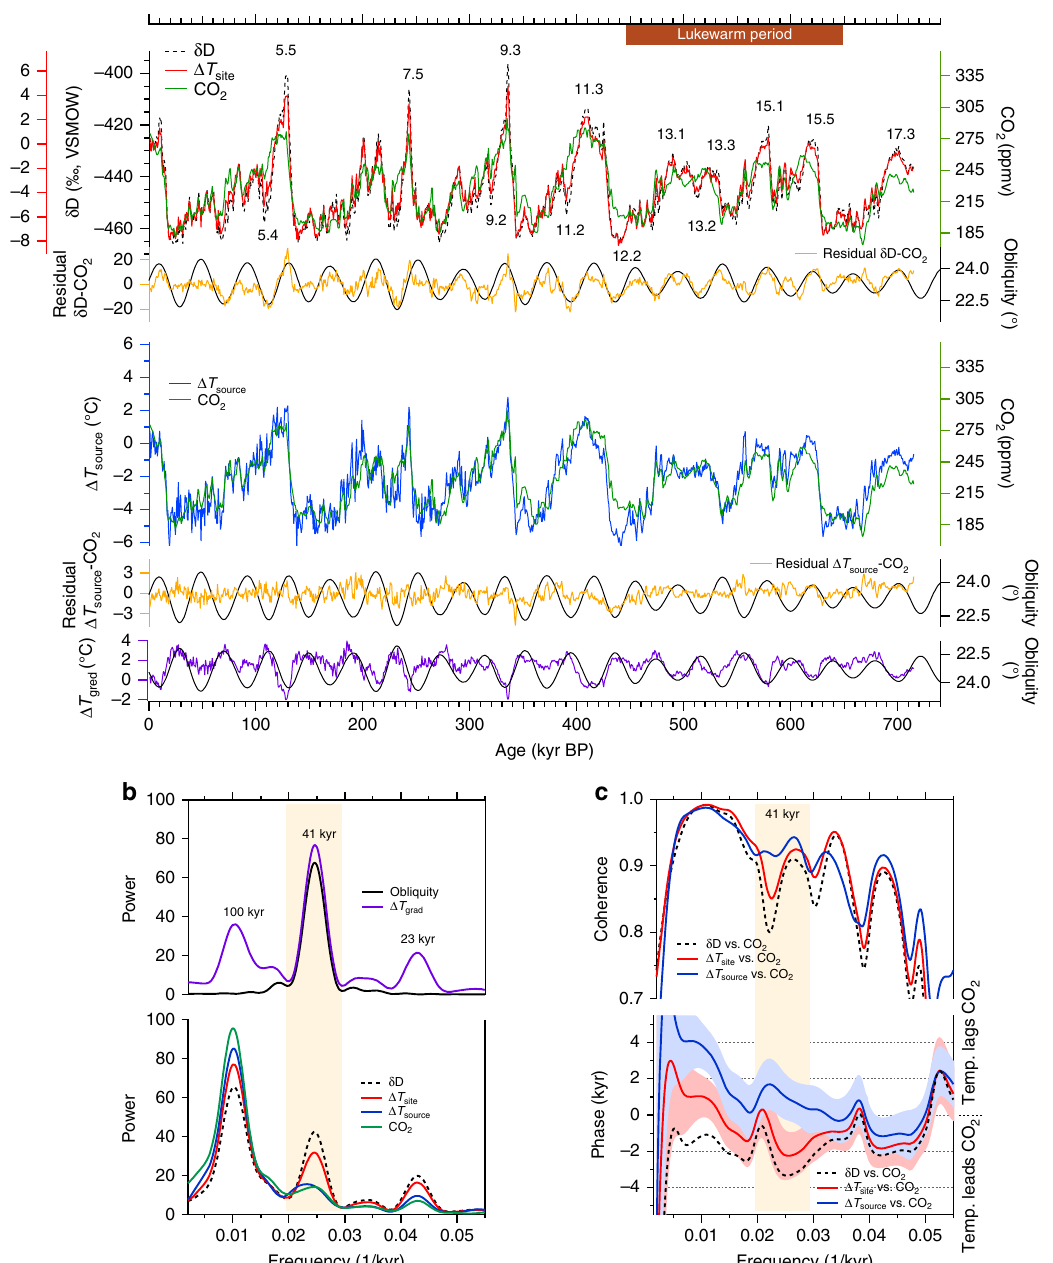
Fig. 3 Temperature reconstructions from the DF2 core together with the CO 2 record. a The upper panel shows the DF δ D (black) and Δ T site (red) records and the CO 2 composite record 32 (green), as well as the residuals from a linear regression between δ D and CO 2 (orange) and obliquity (black). The lower panel shows DF Δ T source (blue) and the CO 2 composite record (green). DF Δ T grad (purple) with obliquity (black) is shown at the bottom. The δ D (or Δ T fi t a linear regression between δ D (or Δ T ’ s source ) axis was scaled to source ) and CO 2 . Numbers indicate Marine Isotope Stages. b Power spectra of Earth obliquity (black) and DF Δ T grad (purple), DF δ D (black dotted), Δ T site (red), Δ T source (blue) and the CO 2 composite record 32 (green). c Upper panel: coherence of δ D vs. CO 2 (black dotted), Δ T site vs. CO 2 (red) and Δ T source vs. CO 2 (blue). Lower panel: same as upper panel but for phase lag. Red and blue colours indicate uncertainty ranges (Methods). The uncertainty range of CO 2 vs. δ D is similar to that of CO 2 vs. Δ T site ; however, it is not shown here for clarity. The obliquity band is shown in